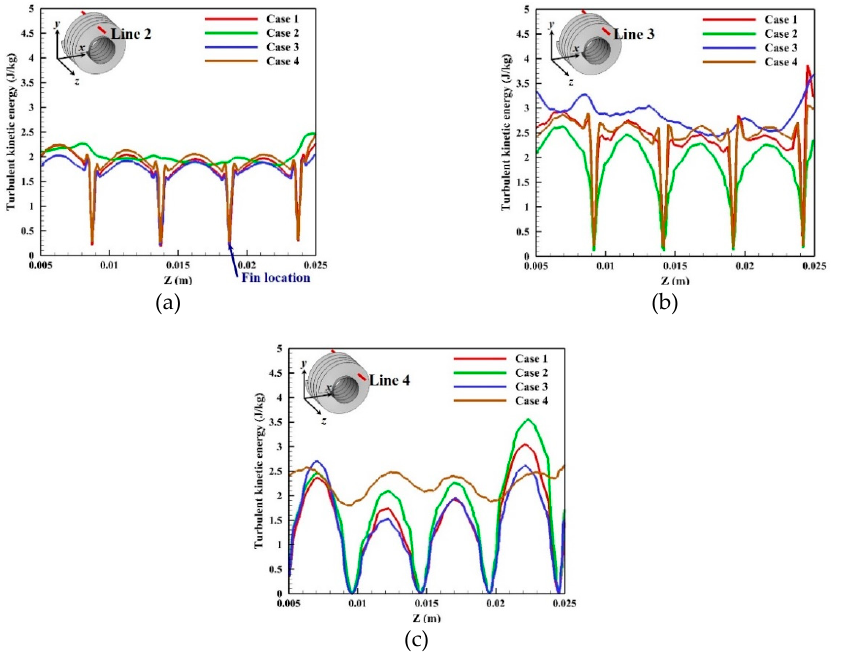
Figure 8. Comparison of turbulent kinetic energy at fixed locations in z ‐ direction at Re = 11,440. Case 1(ref.) is compared with Cases 2, 3, and 4, ( a ) at Line 2 ( y = 0.01452 m), ( b ) at Line 3 ( y = 0.01258 m), and ( c ) at Line 4 ( y = 0.007269 m).